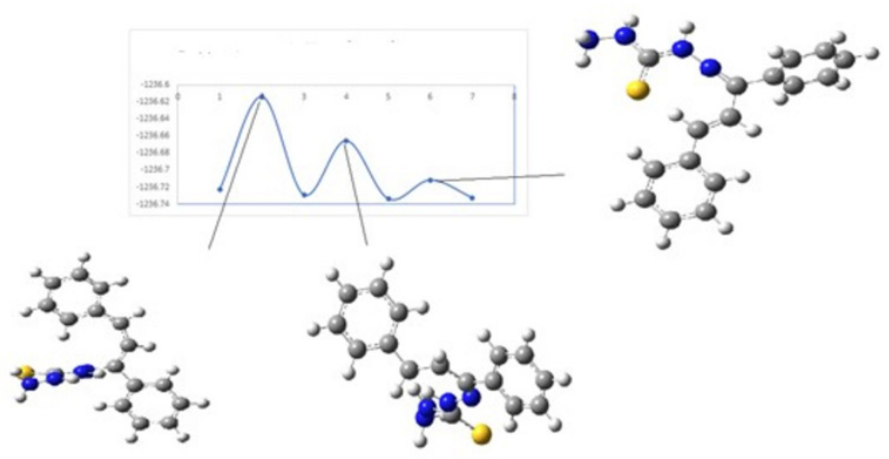
in Hartree, x = conformation) .